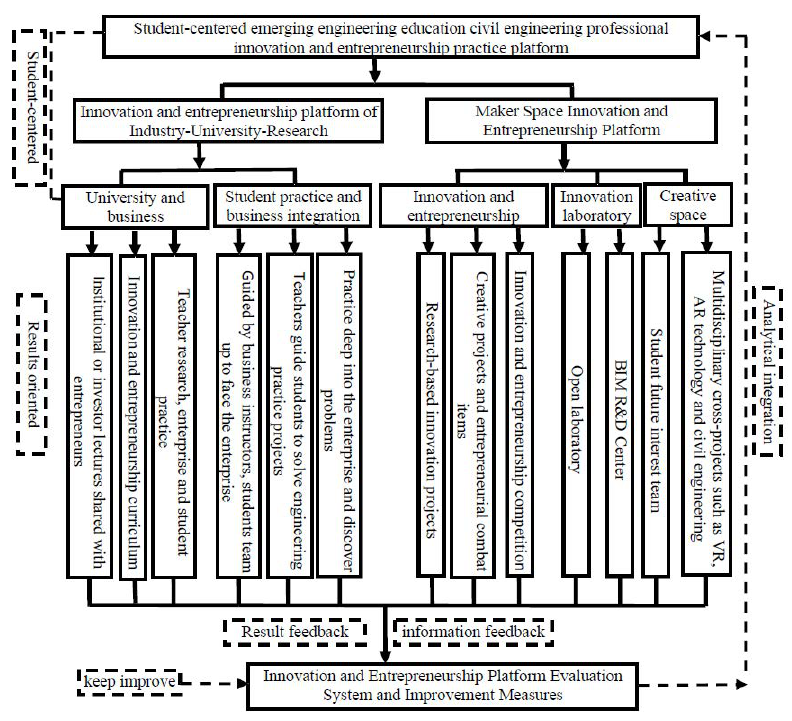
Fig. 3 Innovation and entrepreneurship platform for college